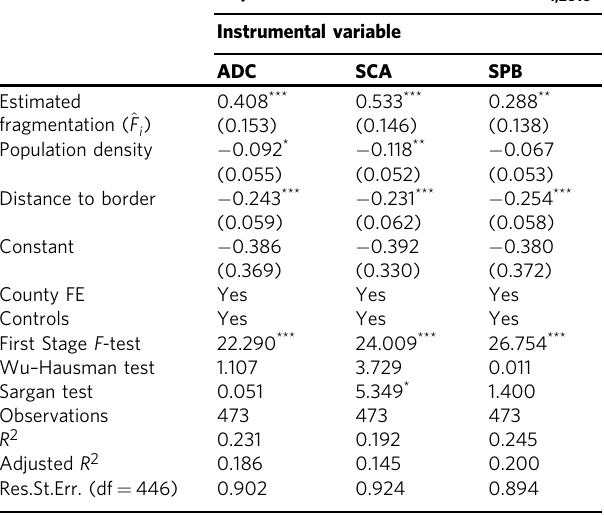
Table 2 We estimate the relationship between social network fragmentation and income inequality using the urban topology indices as instruments for fragmentation using Eq.